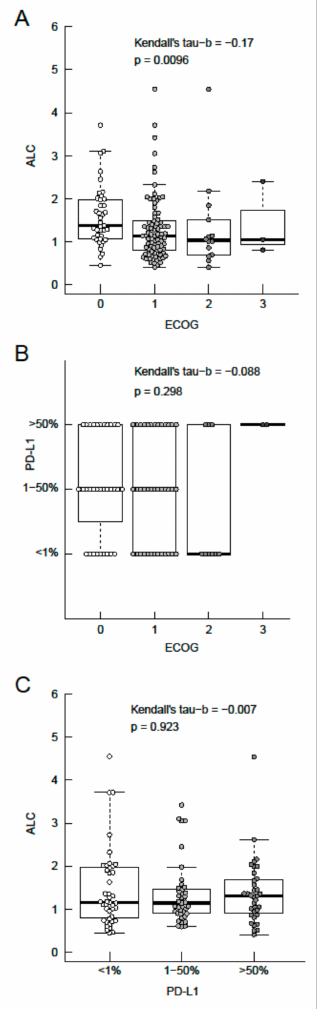
Figure 3. Association between the baseline absolute lymphocyte count (ALC), ECOG performance status, and categorical PD-L1 expression. Association between ALC and ECOG performance status ( A ), categorical PD-L1 expression status and ECOG performance status ( B ), ALC and categorical PD-L1 expression status ( C ). Boxes representing the interquartile range (IQR) from the first quartile (Q1) to the third quartile (Q3) of data, thick line the median, upper whiskers the minimum of (maximum or Q3 + 1.5 × IQR) and lower whiskers the maximum of (minimum or Q1–1.5 × IQR).3.4. Association of Antibiotic Exposure and Survival with Immune-Checkpoint